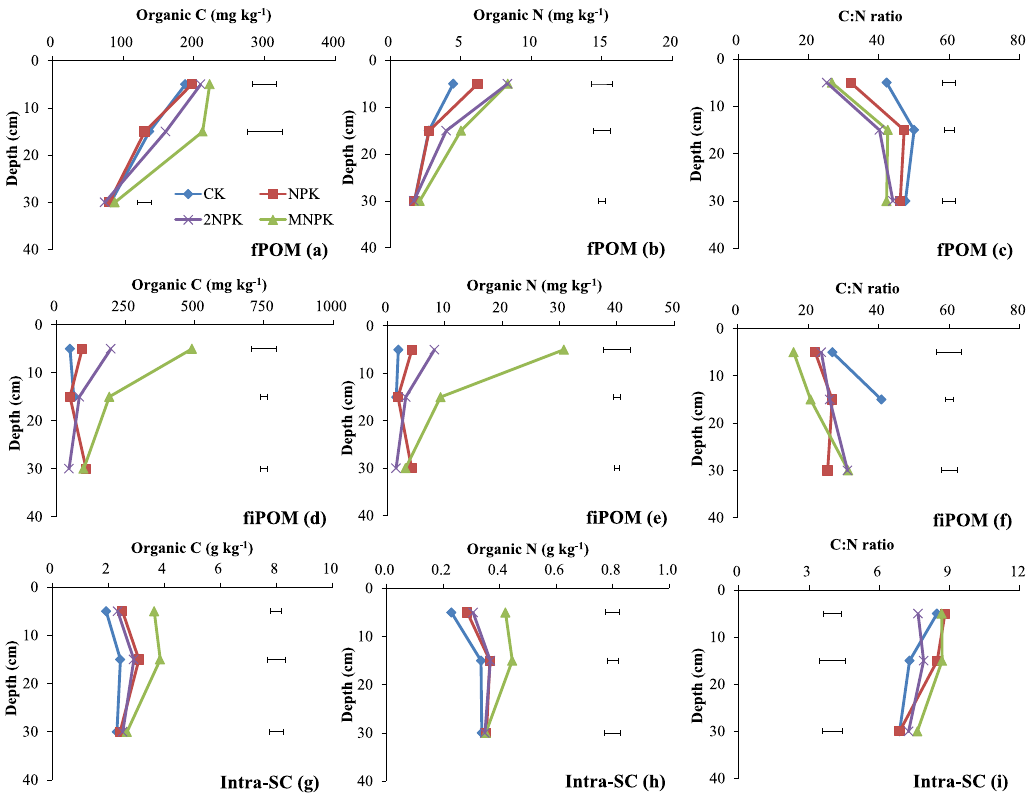
Figure 4. Organic C and N concentrations and C/N ratios in microaggregates in the macroaggregate fractions to 40 cm deep in the control treatment (CK), chemical fertilizer treatments (NPK and 2NPK), and combined manure and chemical fertilizer treatment (MNPK). Each value is the mean of three replicates. The horizontal lines indicate the least significant difference values at the 0.05 level (LSD0.05) for the different treatments at the different depths. Inter-m is the sum of fPOM, fiPOM, and intra-SC. fPOM was not detected at 20–40 cm deep. The abbreviations for aggregates of each size are shown in the footnote to Table